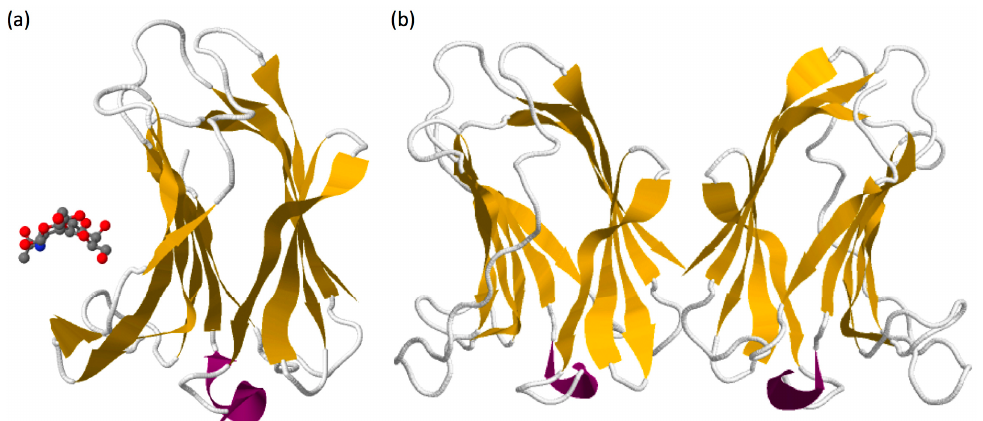
Figure 1. ( a ) Representation of the crystal structure of galectin-7 in complex with LacNAc (PBD 4XBQ) [30]. Carbohydrates are recognized by the residues H49, N51, R53, N62, W69, E72 and R74 forming the CRD. ( b ) Crystal structure of homodimeric galectin-7 (PBD 1BKZ) [18] illustrating the “back-to-back” arrangement of galectin-7 dimers with the two CRD orientated in the opposite direction. Structures obtained from www.rcsb.org.